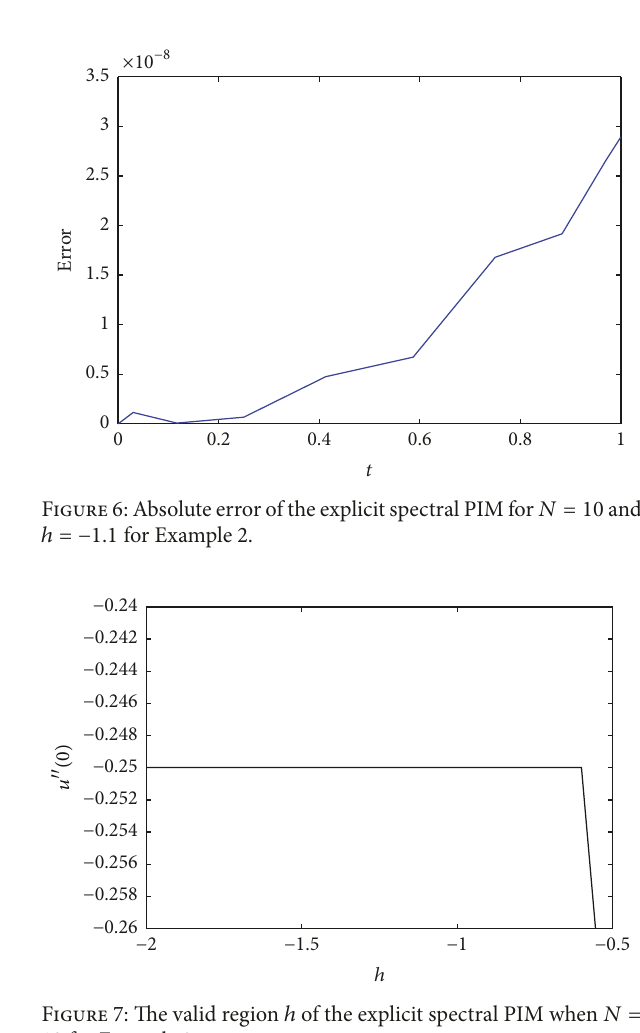
Figure 3: (a) Approximate solution of the explicit spectral PIM for 𝑁 = 15 . (b) Absolute error of the explicit spectral PIM for 𝑁 = 15 and ℎ = −1.47 for Example 1.